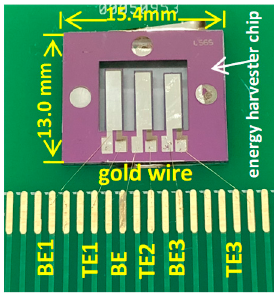
Figure 4. The photograph of the testing structure for the energy harvester.